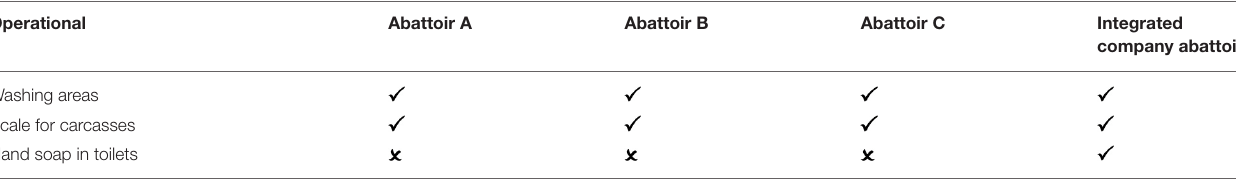
(ii) Distribution of offals: Offals are given as payment to the slaughter men in abattoir A and C. Offals from Abattoirs A and C are then sold to